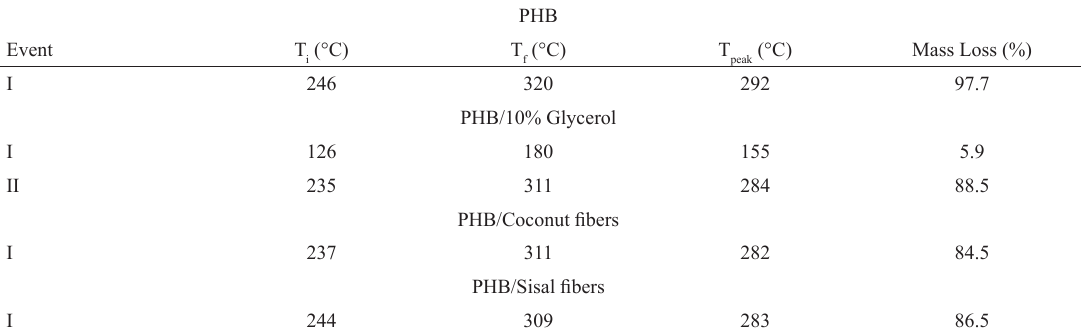
) final temperature (T ), peak temperature (T ) and the percentage loss of mass of events i f peak